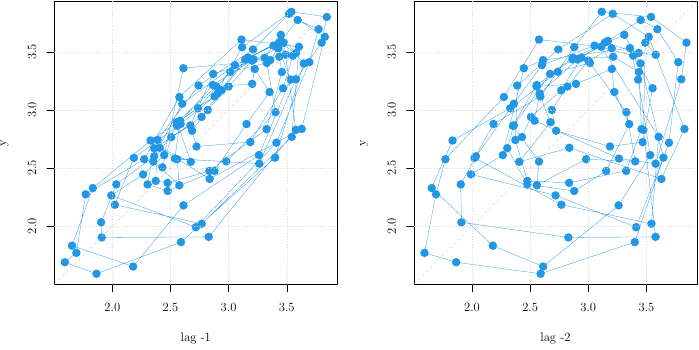
Figure 2 – Lag plot of the time series of the Canadian lynx, from 1821 to 1934. (Left) Lag 1. (Right) Lag 2.